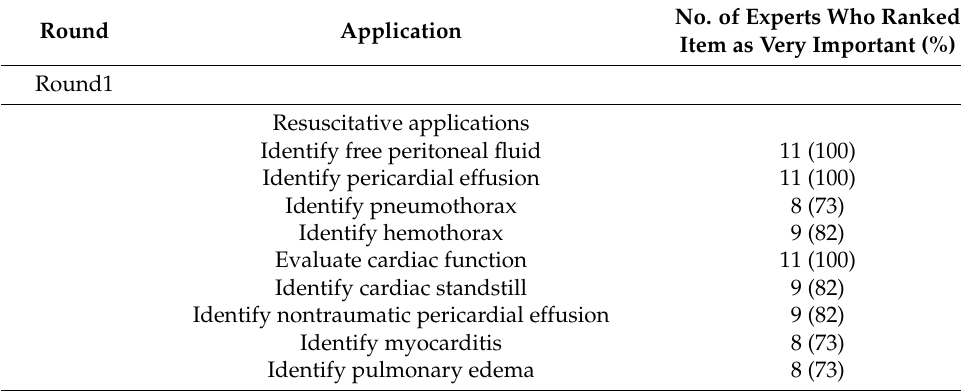
Table 3. POCUS Applications to Include by Delphi